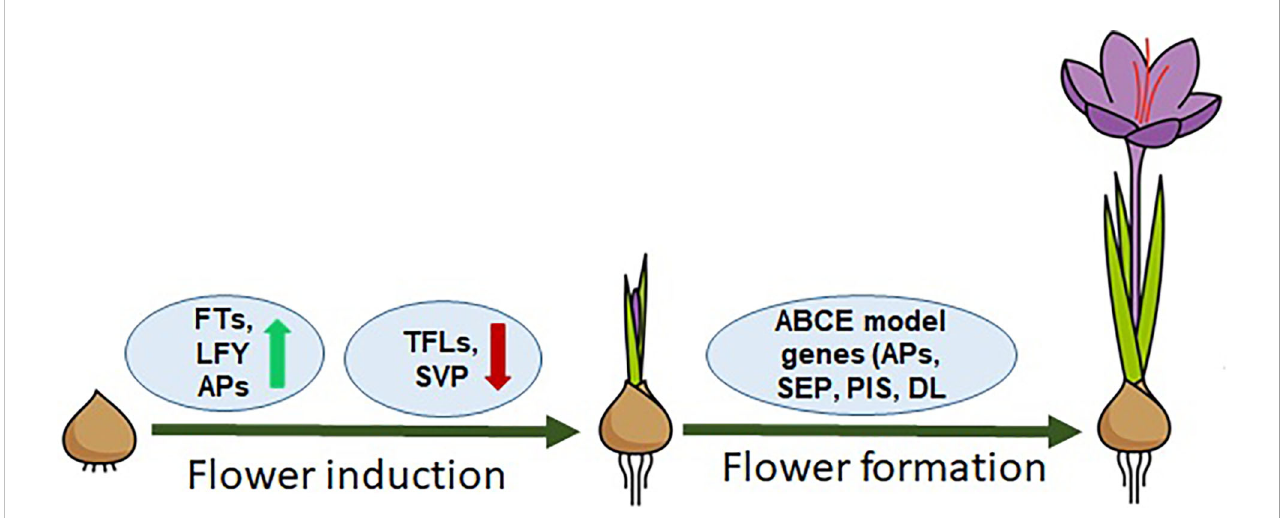
FIGURE 1 Model representing the fl owering regulation in saffron. FT, LFY genes are fl ower inducers; TFLs, SVP are fl owering inhibitors; ABCE model genes: APs, SEPs, PISs, and DLs are homeotic genes/ fl ower